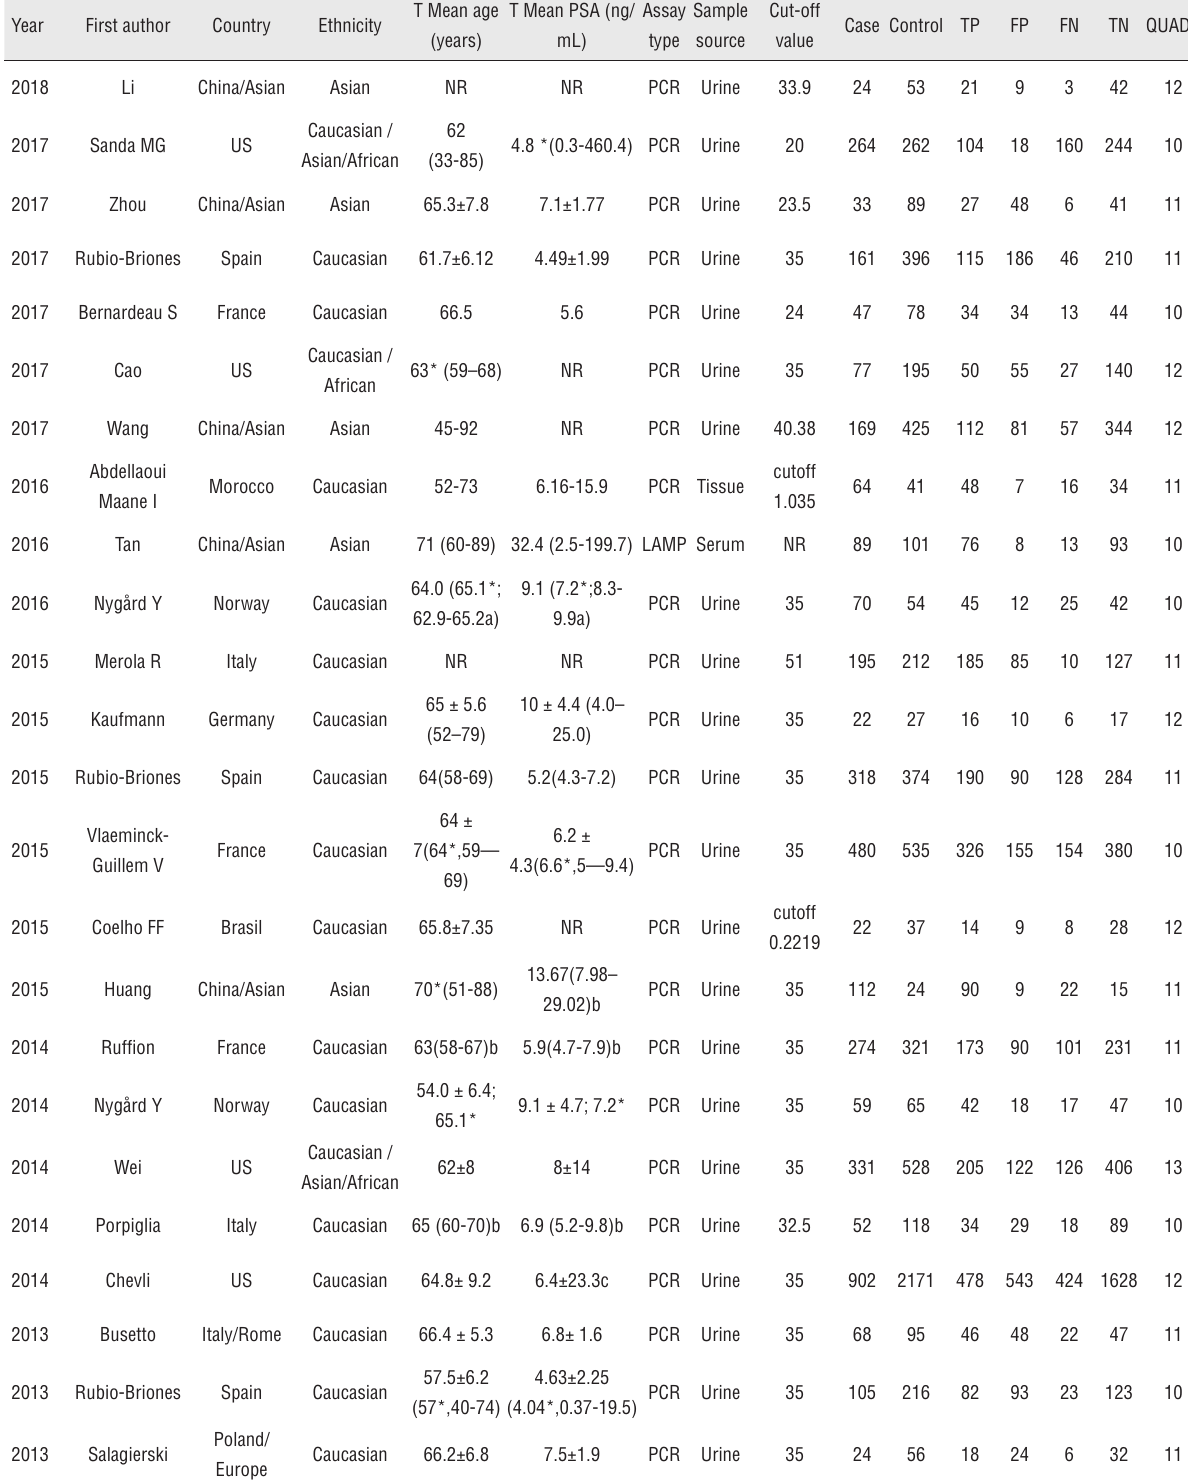
Table 1 - Characteristics and methodology assessment of individual studies included in the